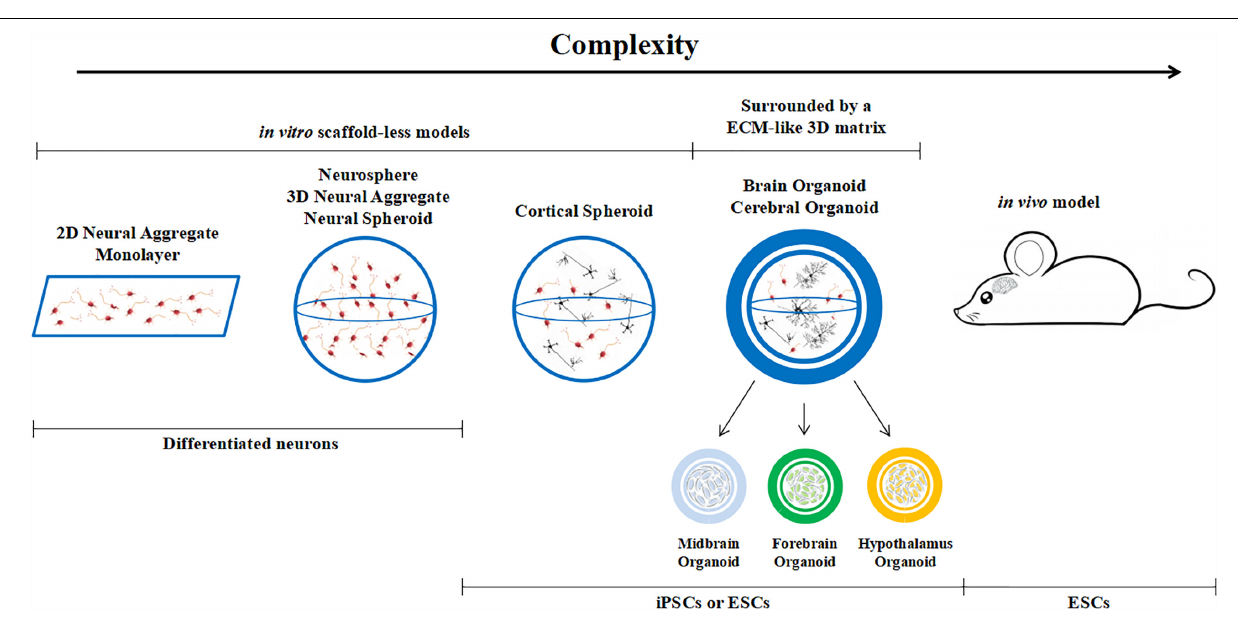
4500 iPSC, neuroectodermal tissues are generated from